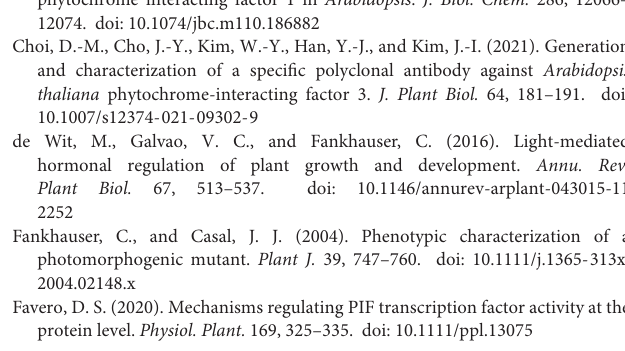
Supplementary Figure 1 | Purified AsphyA mutants used in this study. Supplementary Figure 2 | Kinase activity assay of AsphyA site-mutants with PIF3 as a substrate. Supplementary Figure 3 | Photoaffinity labeling of AsphyA with 2-N3-ATP-biotin-long chain-hydrazone (2-azido-ATP) to represent ATP-binding affinity. Supplementary Figure 4 | Transgenic phyA-201 plants expressing AsphyA mutants. Supplementary Figure 5 | Light-induced nuclear localization of AsphyA kinase mutants. Supplementary Figure 6 | Light-induced degradation of AsphyA proteins. Supplementary Figure 7 | Transgenic phyA-201 plants co-expressing AsphyA and eGFP-fused PIF3 (PIF3:eGFP). Supplementary Figure 8 | Phosphorylation of PIF1 by AsphyA kinase mutants. Supplementary Figure 9 | Production of PIF1-specific polyclonal antibody. Supplementary Figure 10 | FR-induced (i.e., phyA-dependent) seed germination assays. Supplementary Table 1 | Sequences of the primers used in the present study. Supplementary Table 2 | Calculation of the nuclear/cytoplasmic ratios of eGFP-fused AsphyA